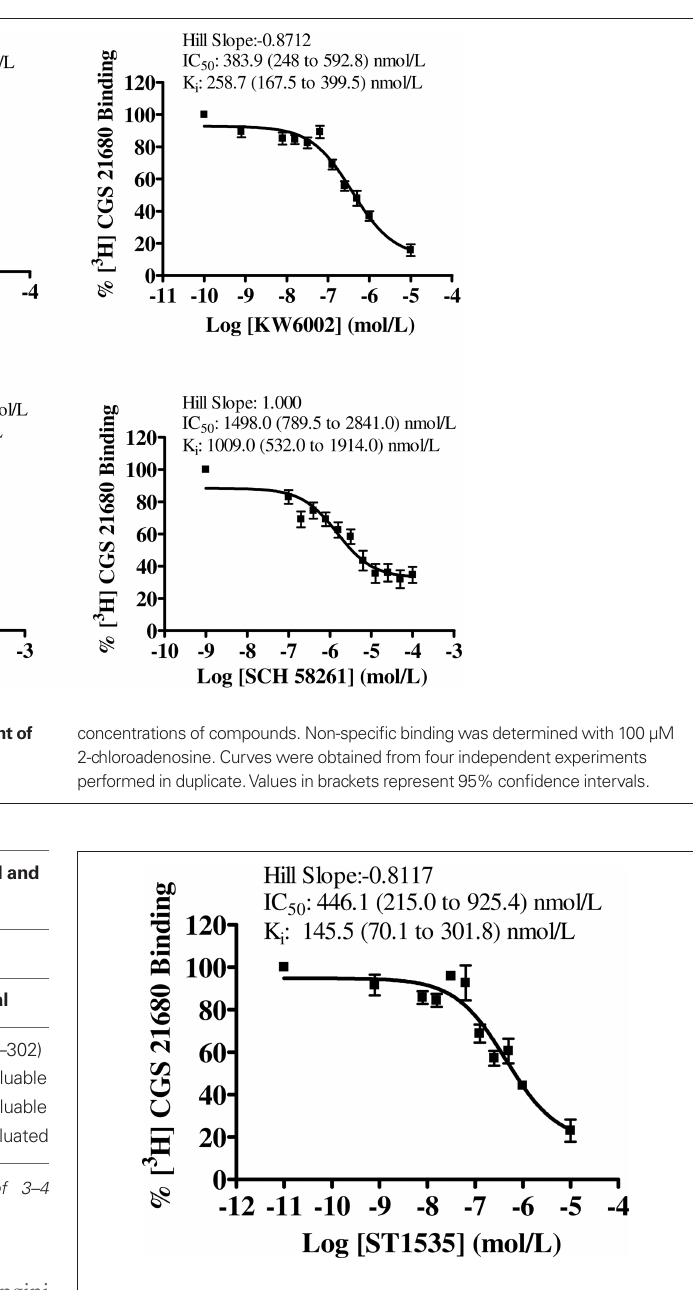
FiGure 5 | Dose–response curves of compound-mediated displacement of [ 3 H]CGS21680 binding to rat hippocampus in the presence of 200 nmol/L CSC, to isolate atypical adenosine A receptors. The ordinates 2A represent the specific binding of 30 nmol/L [ 3 H]CGS21680 in the presence of different concentrations of compounds and a fixed saturating concentration of CSC. Non-specific binding determined with 100 μM 2-chloroadenosine. The curve was obtained from three independent experiments performed in duplicate. Values in brackets represent 95% confidence